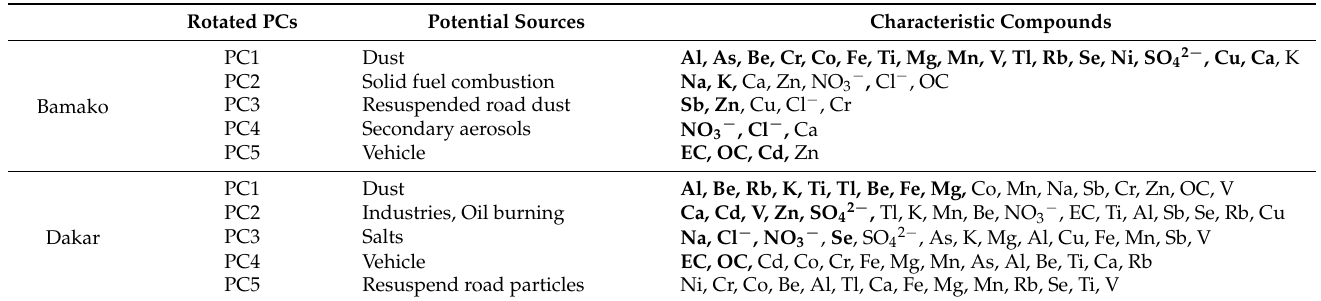
Table 3. Principal component (PC) and potential source associations (chemical species with high factor loadings are in bold, while the other species have moderate factor